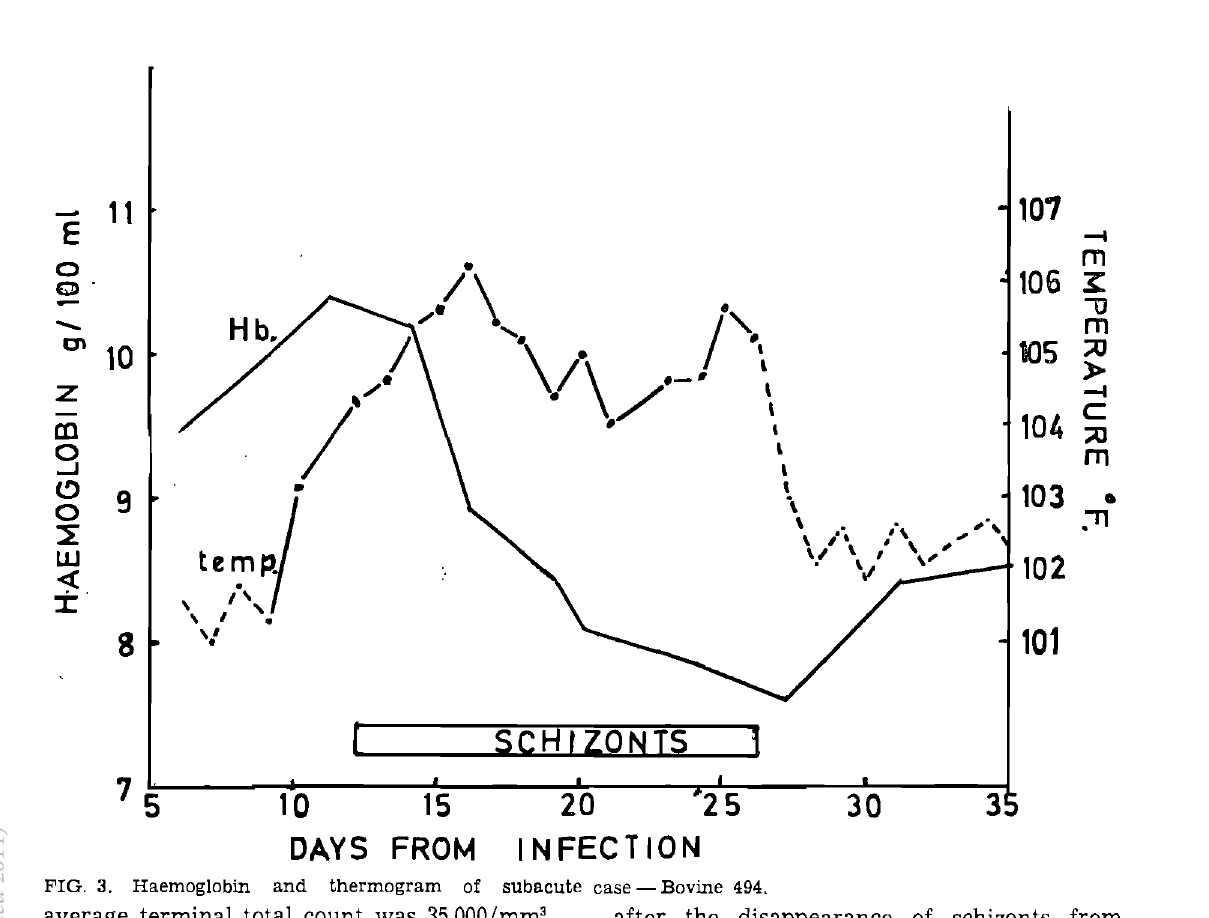
FIG. 3. Haemoglobin and thermogram of subacute case - Bovine 494. average terminal total count was 35000/mm 3, after the disappearance of schizonts from but Bovine 803 showed a maximum figure the blood and lymph nodes. of 6700/mm 3, the lymphocyte. count